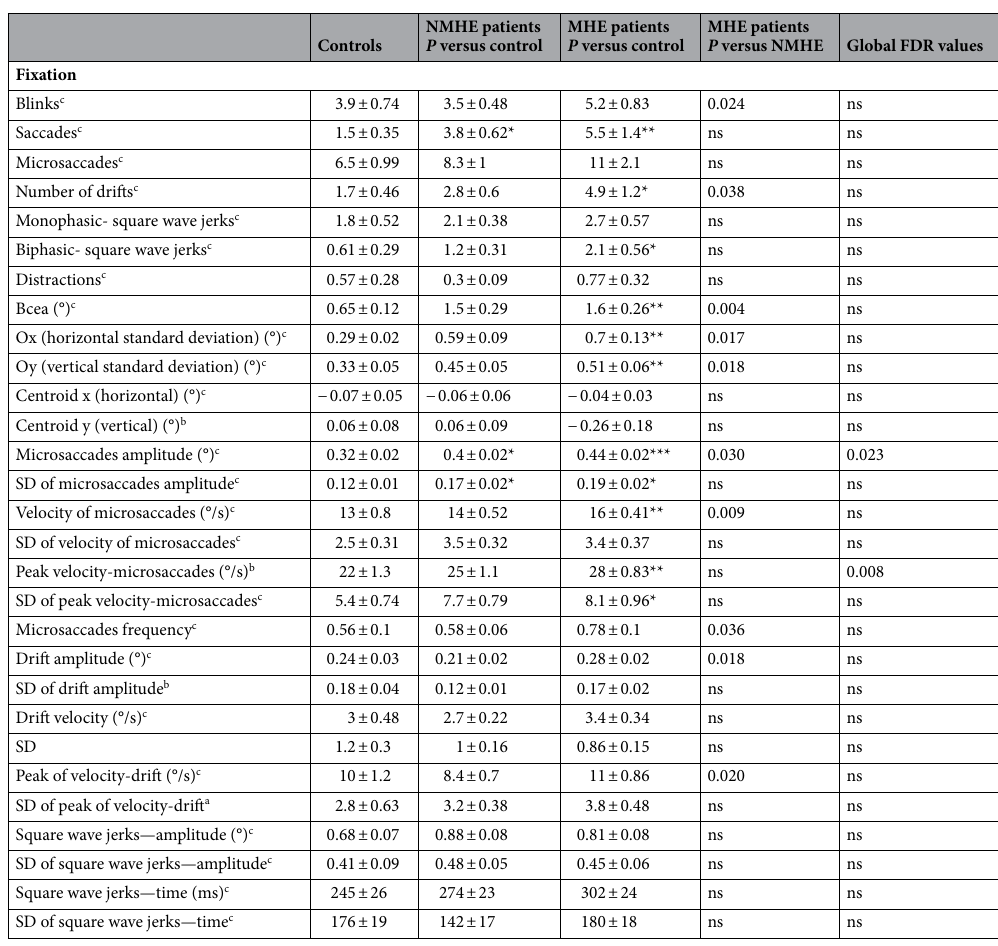
Table 4. Results of eye movement tests in the three groups of study. Fixation test. All values are expressed as mean ± SEM. Abbreviations: NMHE and MHE, patients without and with minimal hepatic encephalopathy according to PHES; SD, Standard deviation. Differences between groups were analyzed using one of three possibilities: one-way ANOVA followed by Tukey’s multiple comparison test (a) parametric and homoscedastic variables, Welch’s ANOVA followed by Games-Howell’s multiple comparison test (b) for parametric but non-homoscedastic variables, and Kruskal–Wallis followed by Dunn’s multiple comparison test (c) for non-parametric variables. Significant differences compared to controls are indicated by asterisks: * p < 0.05; ** p < 0.01; *** p < 0.001; ns, non-significant. Detailed definitions of eye movement variables are in Supporting